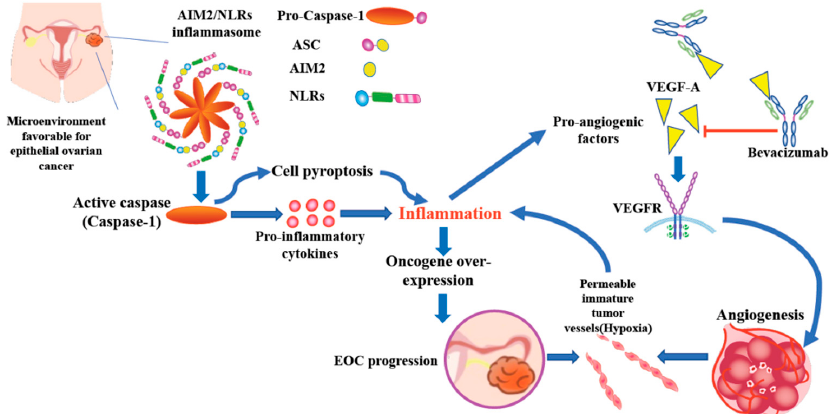
Figure 5. Working model of a possible link between AIM2 inflammasome and anti-angiogenesis treatment in EOC. Hypoxia in ovarian cancer environment induced chronic inflammation and damage associated molecular patterns (DAMPs). Inflammasome related genes (AIM2, NLRP3 . . . ) were activated afterward. Inflammatory cytokines which were released due to cell pyroptosis by activated caspase, inducing oncogene over-expression then EOC progression. The inflammatory reaction can also induce production of pro-angiogenic factors and promote angiogenesis. Bevacizumab acts as a direct VEGF inhibitor to suppress tumor